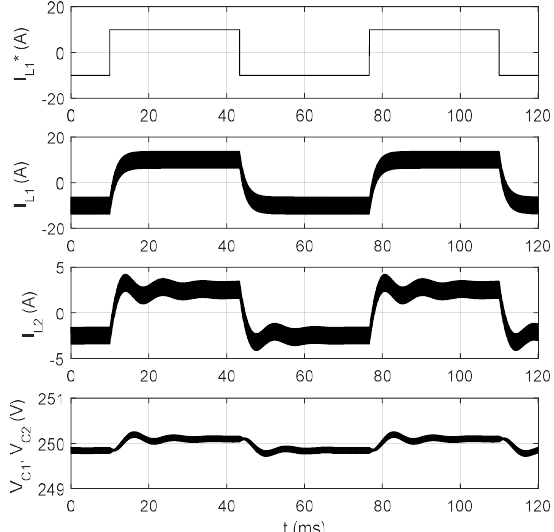
= ± 10 A , V H = 400 V, V L = 80 L 1